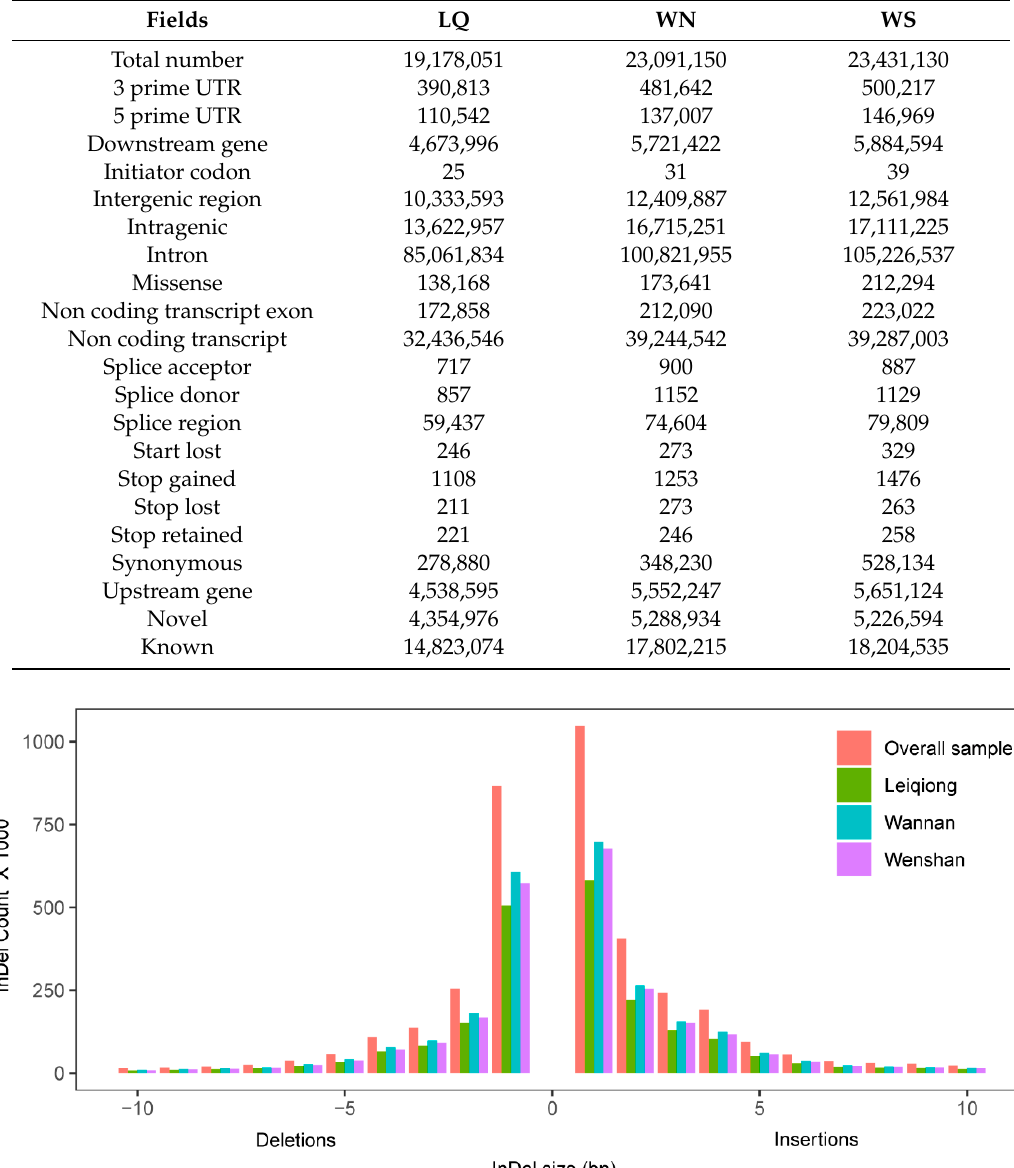
Table 2. Functional annotation of the detected SNP variants in three cattle breeds.